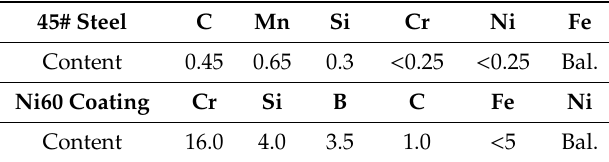
Table 1. Raw materials used for 45# steel-Ni60 coating.